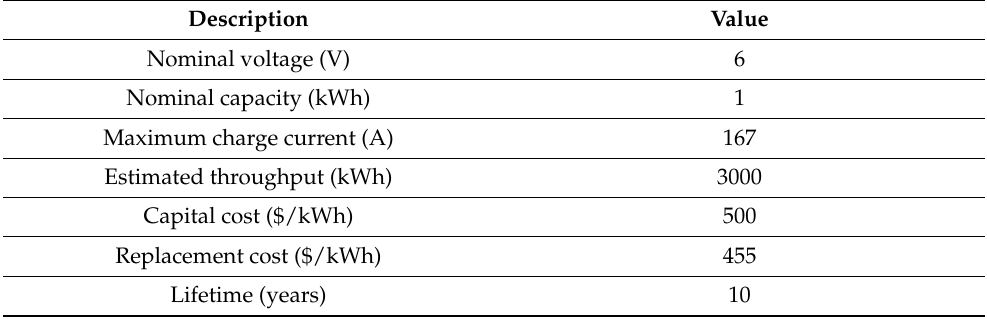
Table 4. Technical specifications of the